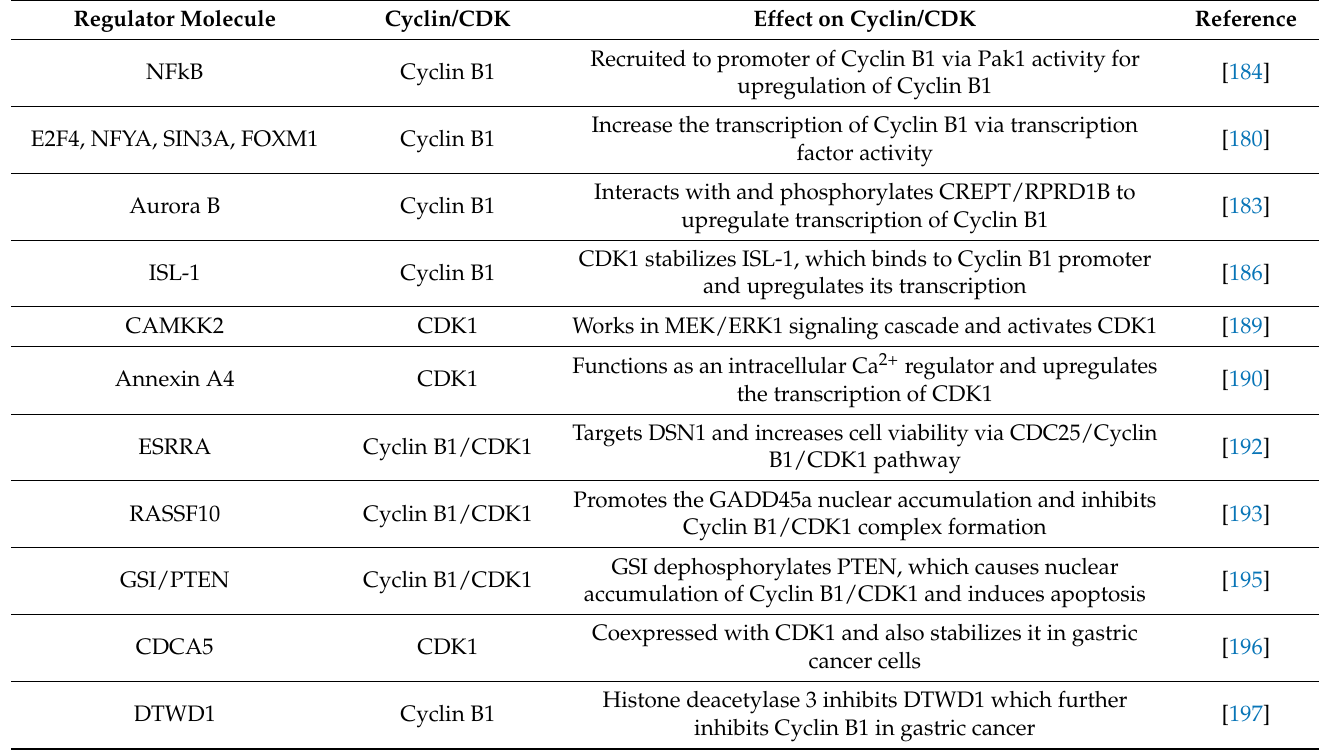
Table 8. The upstream regulators of the Cyclin B1/CDK1 axis studied in gastric cancer are listed with their mode of